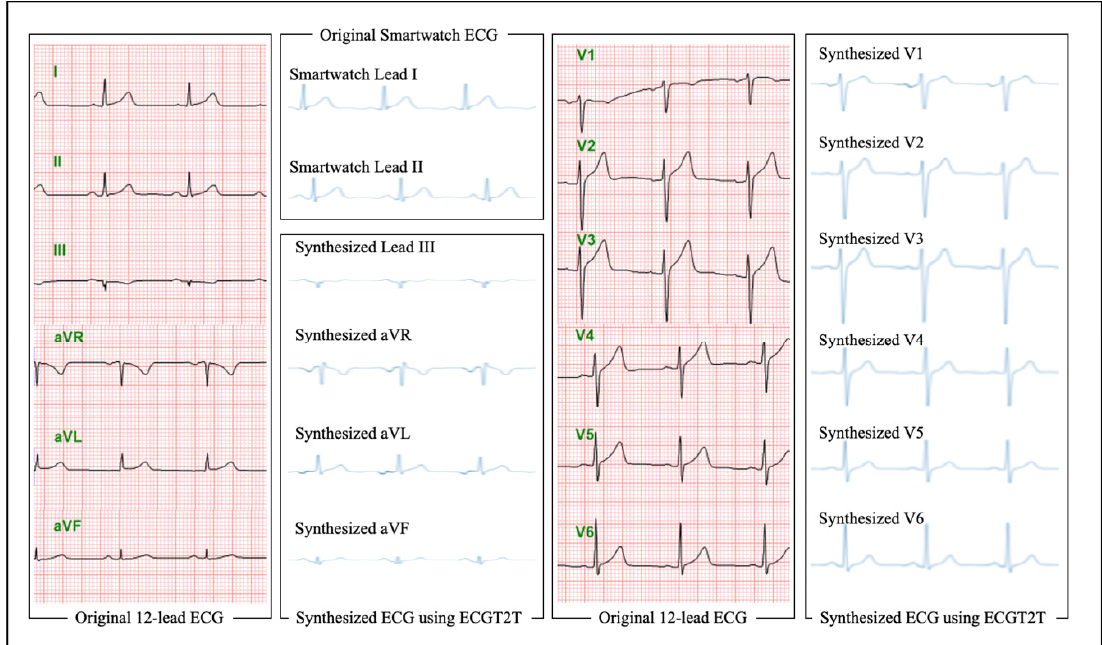
Figure 3. 12-lead ECG generation using smartwatch ECG based on ECGT2T. Legend: ECG denotes Figure 3. 12 ‑ lead ECG generation using smartwatch ECG based on ECGT2T. Legend: ECG denotes electrocardiography and ECGT2T ECG synthesis from two-lead to electrocardiography and ECGT2T ECG synthesis from two ‑ lead to ten ‑ lead.